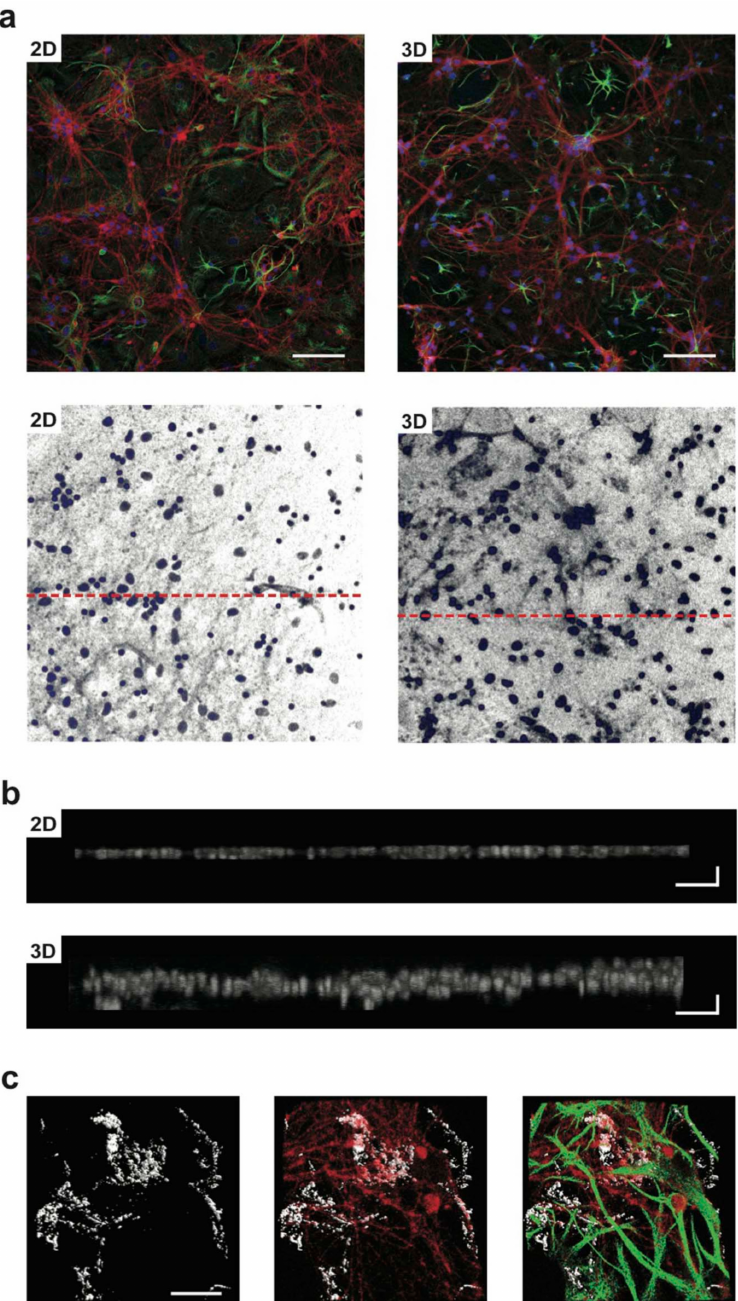
Figure 2. The development of primary neurons in 2D- or 3D-PDMS scaffolds. In ( a ) (top row), confocal micrographs show hippocampal cultures grown (9 DIV) on 2D-PDMS (left) and 3D-PDMS (right) immune-stained for β -tubulin III (in red), GFAP (green), and DAPI (blue). Scale bar: 100 mm. In the bottom row’s images, only the DAPI channel is selected to highlight the nuclei under the two culturing conditions (same visual fields as in ( a ) top); the dashed red lines represent the regions for which the z profile reconstructions are performed in ( b ) note the increased thickness of DAPI signal in the 3DPDMS. Scale bar: 100 × 10 µ m. In ( c ), a confocal reconstruction of a 3D-MWCNT scaffold (left; in grey carbon nanotubes are visualized by confocal under reflection mode acquisition, allowing to visualize the scaffold structure); confocal reconstruction of neurons (in red; middle) grown suspended within a pore and glia cells (in green; merged in the right panel) acting as a support. Note the complex growth of neuronal and glial processes exposed to the third dimension. Scale bar: 50 µ m. Adapted with permission from Ref.